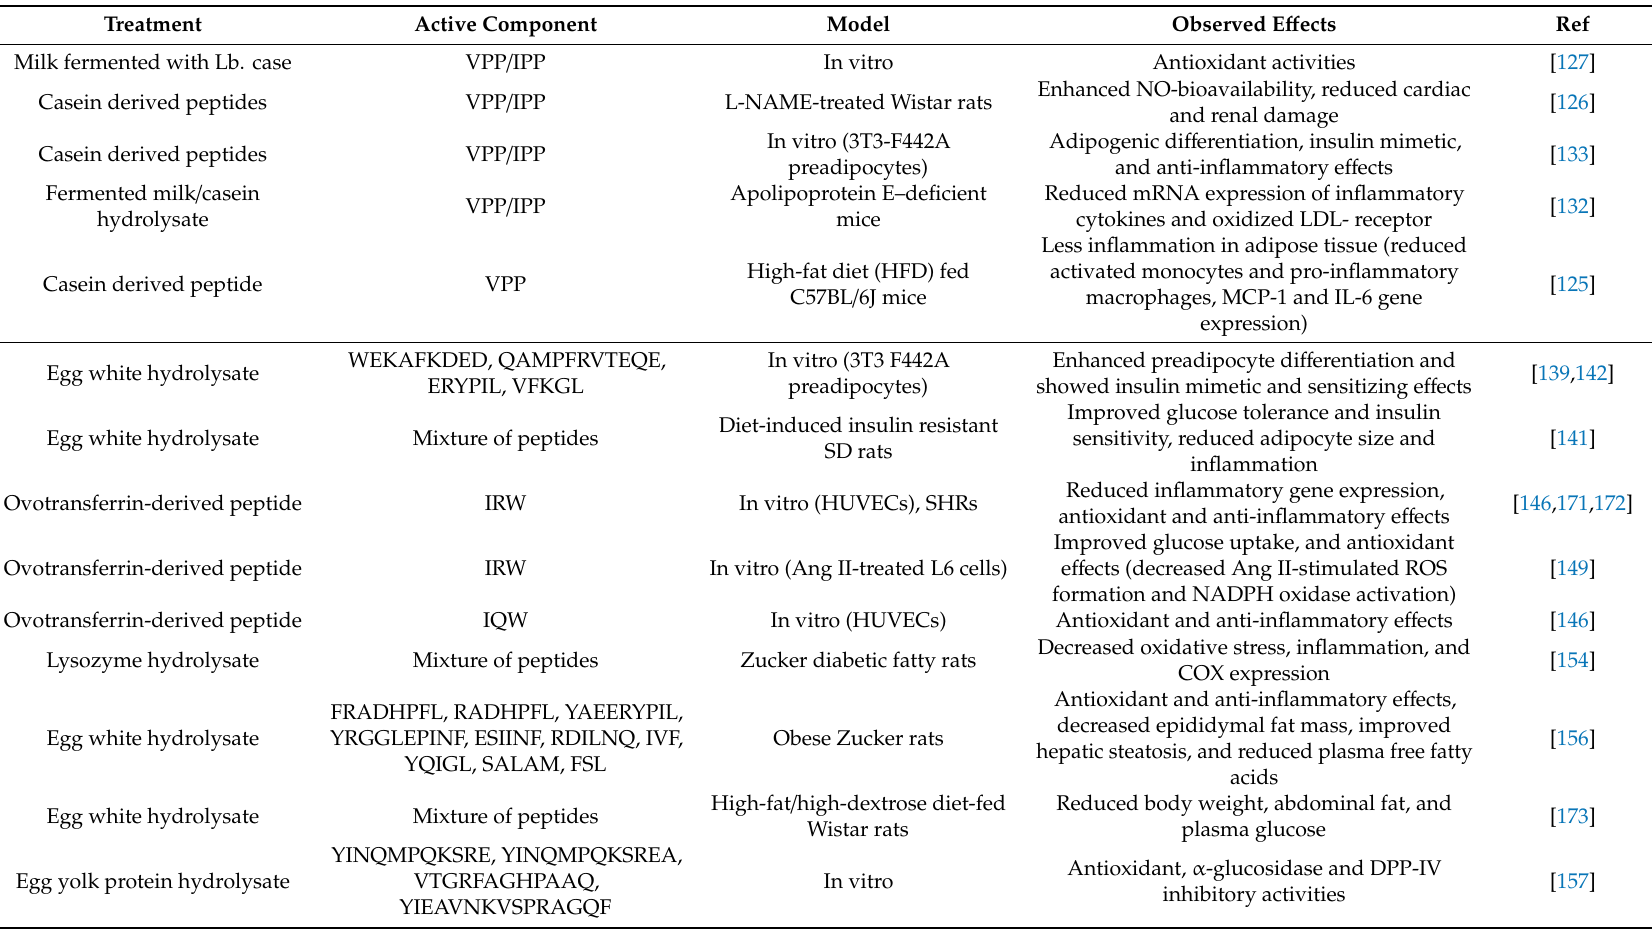
Table 1. Antihypertensive protein hydolysates / peptides with physiological e ff ects on other complications of the metabolic